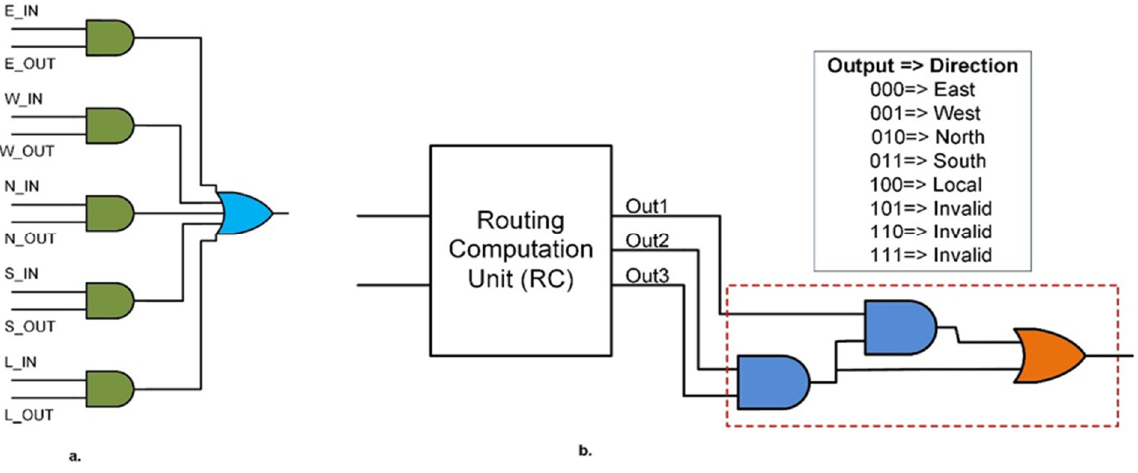
Fig. 9: RC Fault Detection Checkers (a) Wrong Output Port (b) Invalid Output Port ALGORITHM-1: FCU IS WORKING IN PAIRED